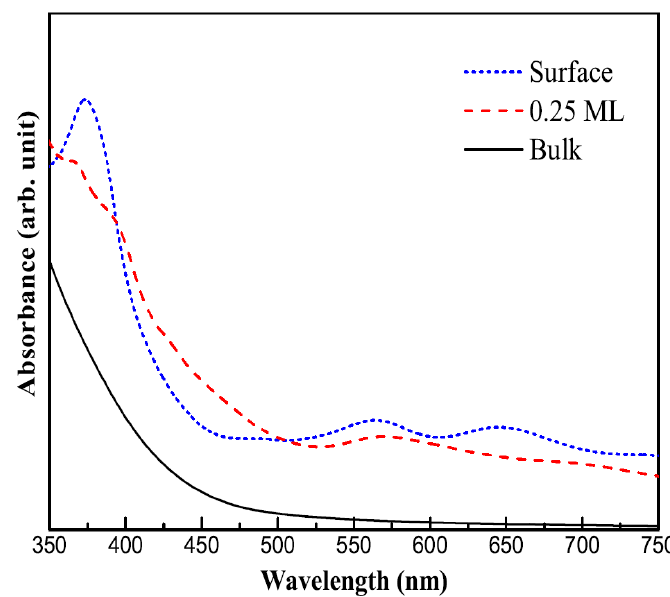
Figure 8. The calculated optical absorption curves of Cu 2 O bulk, clean and Bi adsorbed Cu 2 O(100)